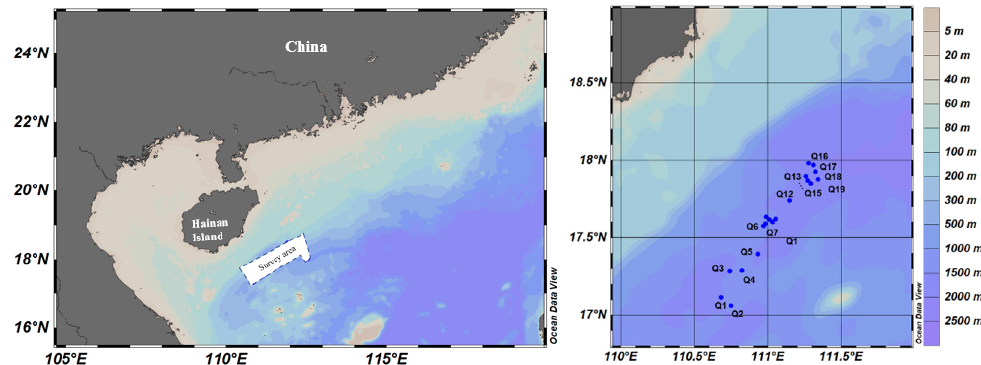
Figure 3. Distribution map of water depth and station position in the Qiongdongnan Sea in the South China Sea.